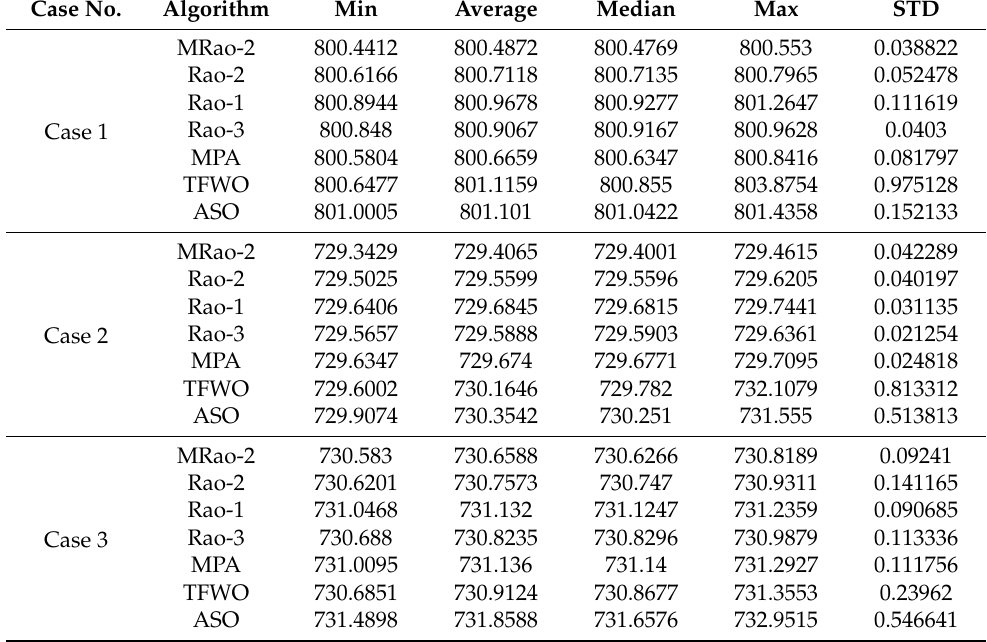
Table 8. Statistical results comparison of investigated cases for IEEE 30-bus system for different recent optimization